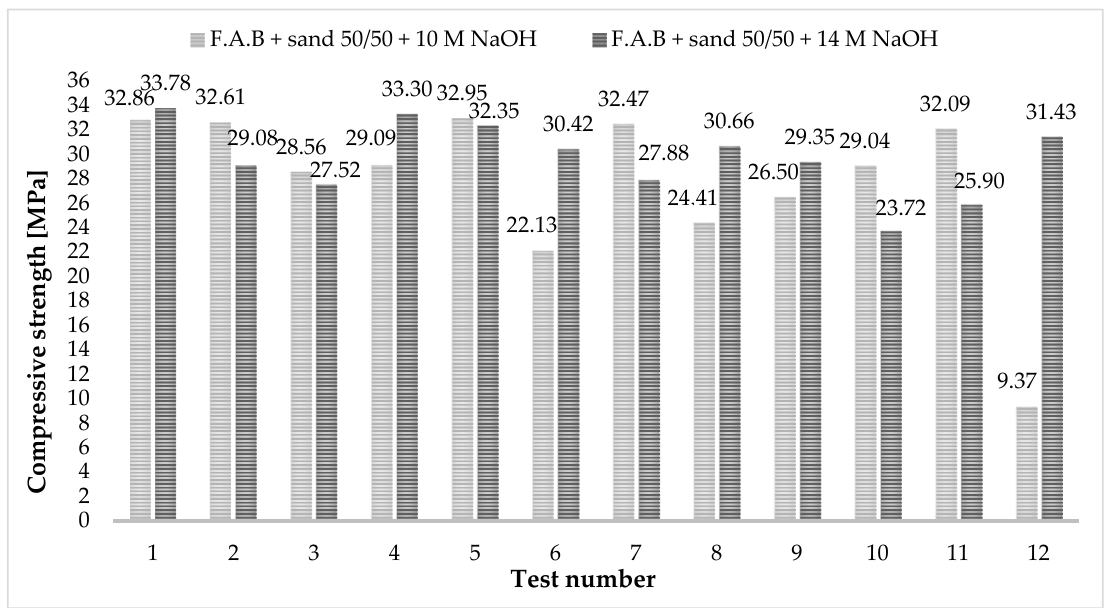
Figure 2. Compressive strength of the Belchatów lignite fly ash samples.